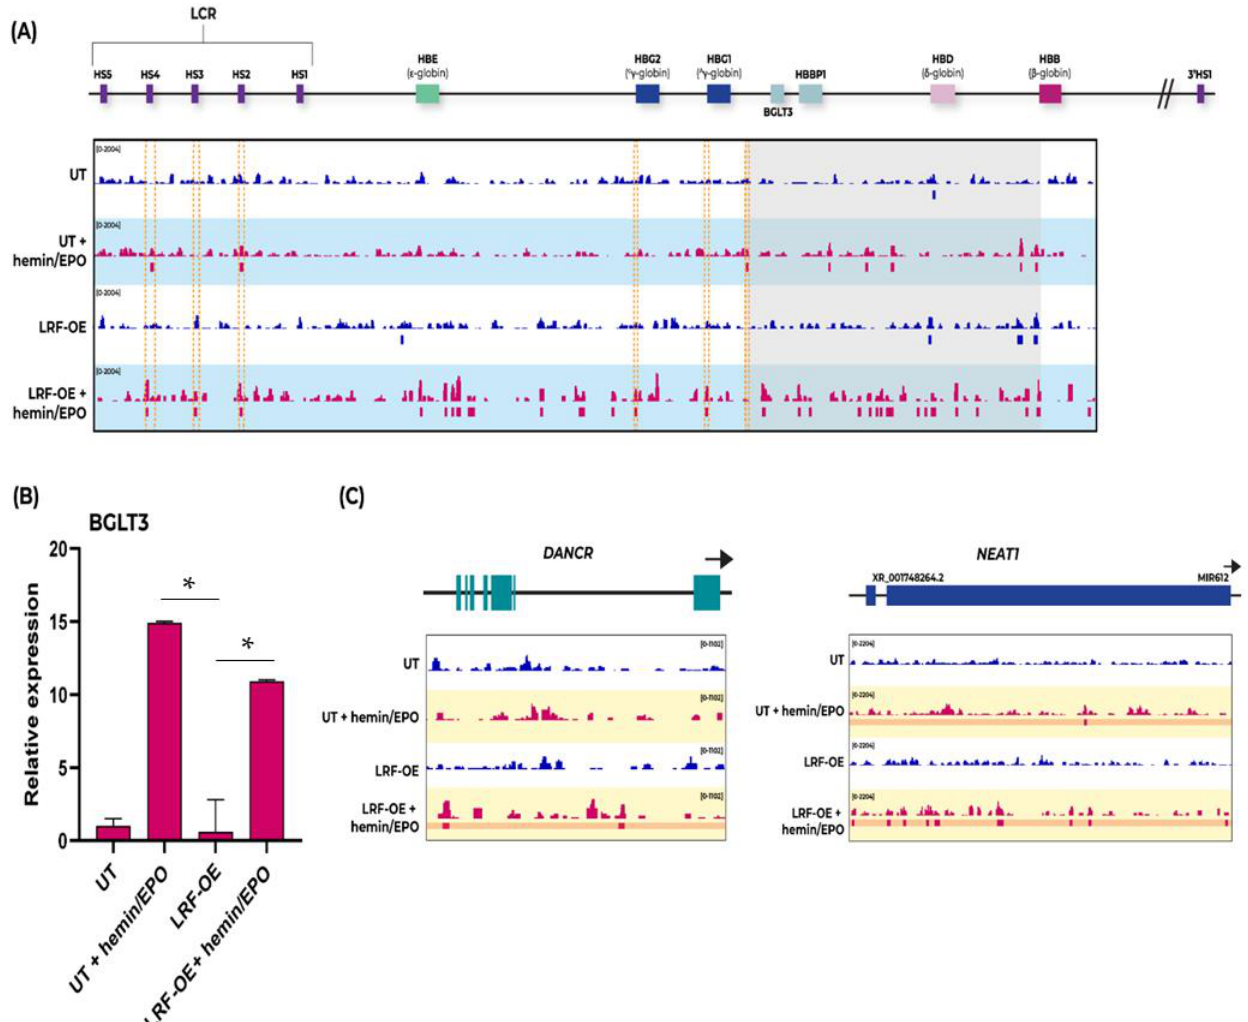
Figure 3. LRF/ ZBTB7A occupancy sites at “ HBB locus” and BGLT3 – lncRNA expression levels. ( A ) Tracks display ChIP-seq data of LRF/ ZBTB7A occupancy and calculated peak enrichment sites for each sample. Reads for untransfected (UT) and LRF-overexpressing (OE) K562 cells, before and after erythropoiesis induction across “ HBB locus” including β LCR are depicted. LRF/ ZBTB7A occupancy sites starting from BGLT3 gene and across the intergenic region towards the HBB gene are highlighted in the grey background. ( B ) Relative expression of BGLT3 -lnc RNA in LRF-overexpressing (OE) K562 cells pre- and post-hemin/EPO induction. Values were normalized to untransfected (UT) non induced cells. * p < 0.05. ( C ) ChIP-seq data of LRF/ ZBTB7A occupancy sites pre- and post- hemin/EPO induction at genetic loci expressing DANCR- and NEAT1-lncRNAs, reported to